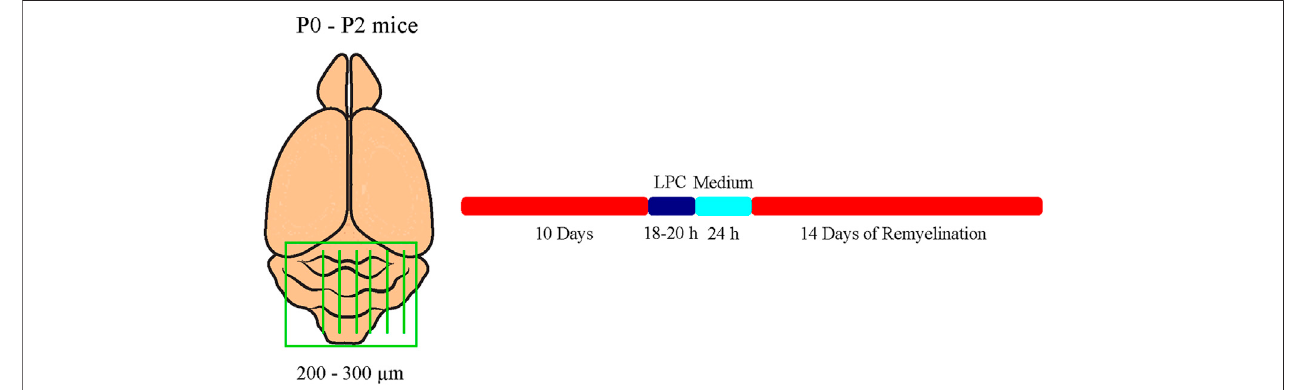
FIGURE1| Experimental setupofthecerebellarexplantcultures.Cerebellaofnewborntenascin-Candtenascin-Rknockoutandwildtypemicepupswerecutinto 250 – 300 µm thick sagittal sections and cultivated in slice culture medium. Demyelination was induced by administration of 0.5 mg/ml lysolecithin to the medium for 16- 18 h. For remyelination analysis, explants were cultivated for further 14 days. Untreated control explants (C) were kept for the whole duration of the experiment.